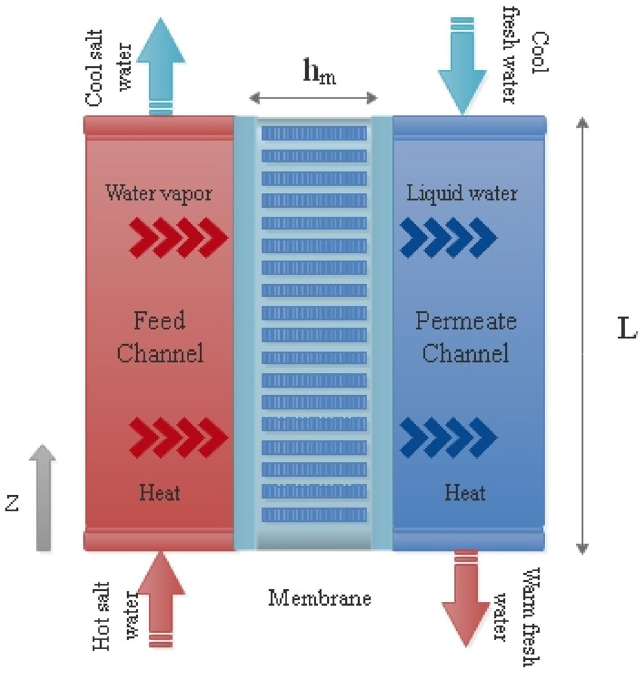
Figure 1. The schematic of the DCMD